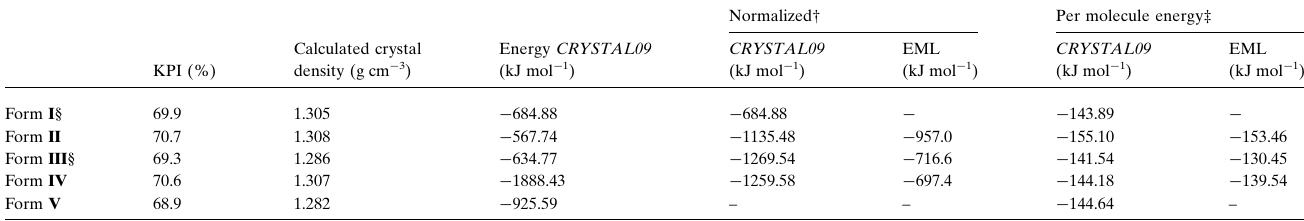
Table 2 KPI, crystal densities and energies for the compounds in this study.